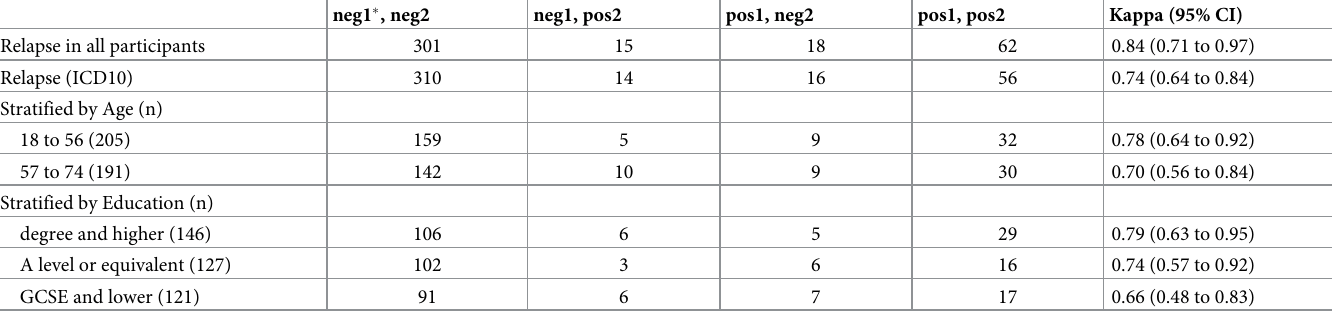
Table 3. Level of agreement for relapse in depression between 1 st and 2 nd completion of retrospective CIS-R: Numbers and kappa.